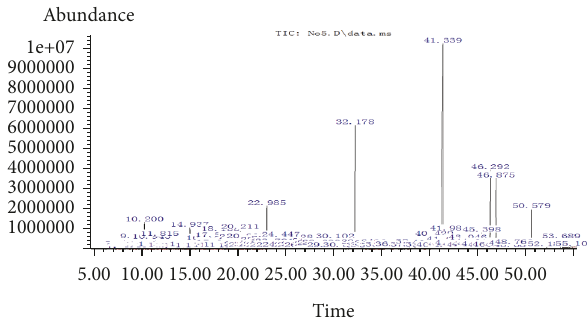
Figure 1: Ion current spectrum of the extract of Plectranthus tomentosa